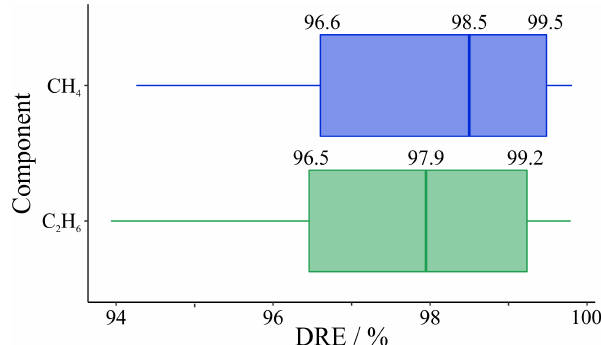
Figure C1. Box and whisker plots of combustion efficiencies calcu- lated without C 2 H 6 (Eq. 2; orange, top row) and with C 2 H 6 (Eq. 3; green, bottom row).